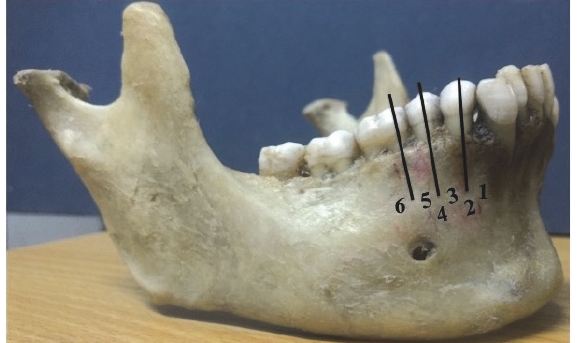
Figure 1: The position of the mental foramen with respect to the teeth of the lower jaw. Position 1: situated anterior to the first premolar; position 2: in line with the first premolar; position 3: between the first and second premolar; position 4: in line with second premolar; position 5: between the second premolar and first molar; position 6: in line with the first molar.